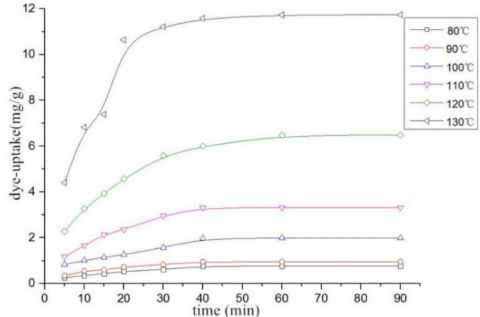
Figure 6. The fitting of GRNN model with dye-uptake of polyester fiber at the condition of 20 MPa.